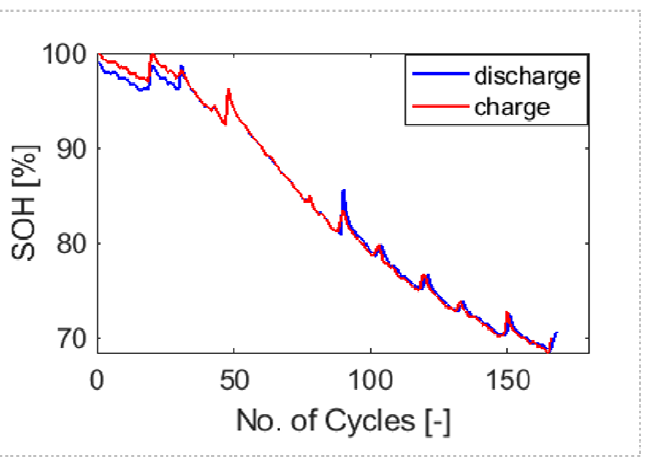
Figure 2. Similarity of state of health (SOH) in the charge and discharge phases. SOH of B0005 is shown to decrease with the number of